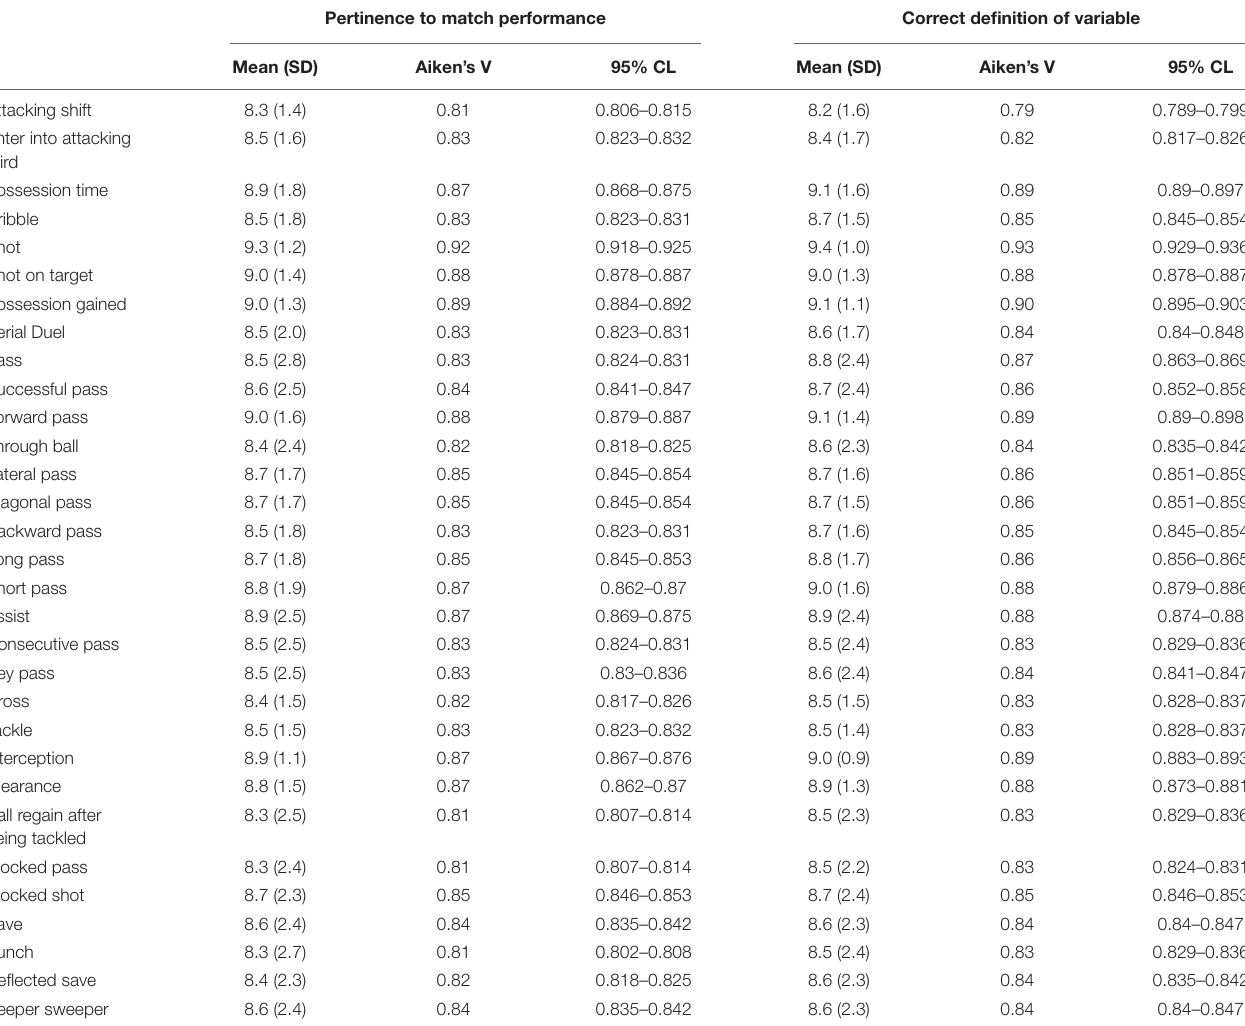
TABLE 2 | Evaluation by 20 expert judges of the pertinence and definition of performance variables. Pertinence to match performance